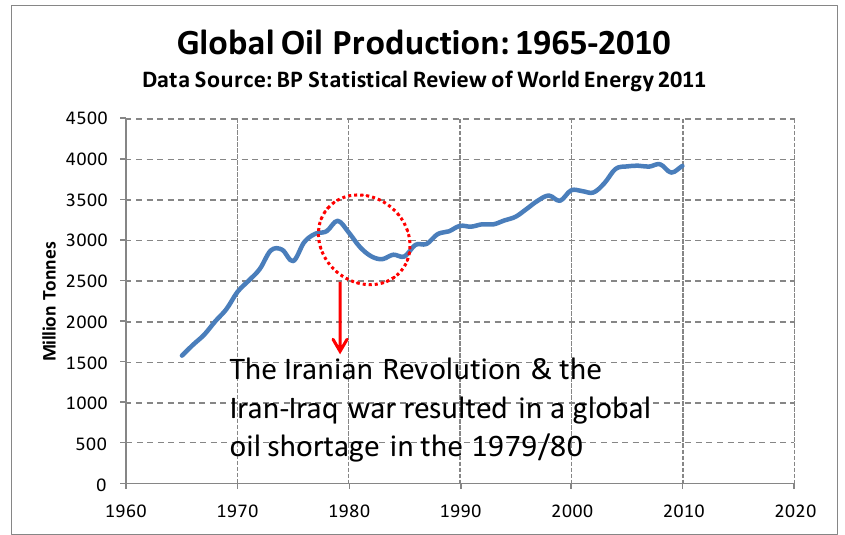
Figure 2. The global oil production between 1965 and 2010. The 1979/1980 Iranian Revolution had resulted in a drop in oil production that had spurred another round of oil crisis. Data were obtained from [24] and plotted by the